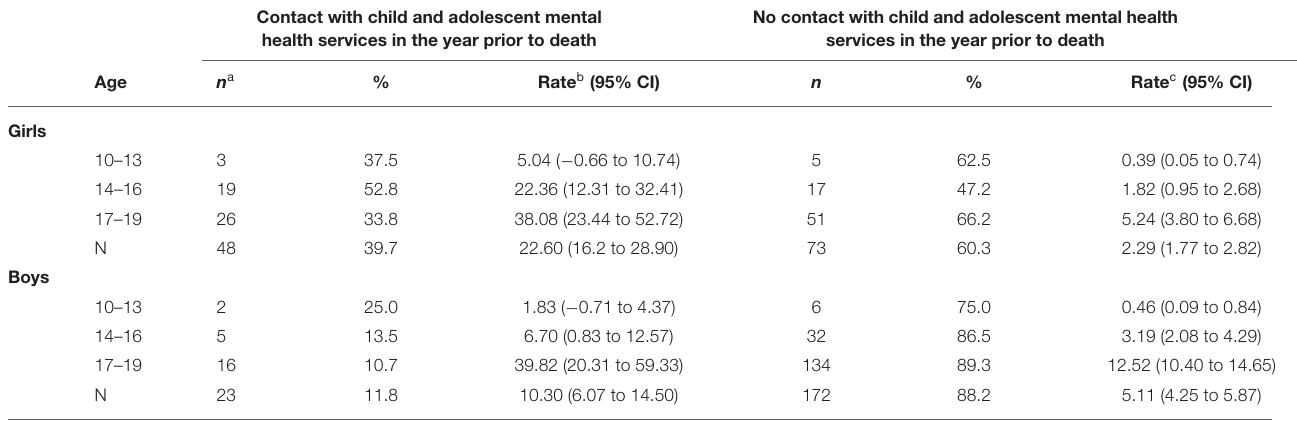
TABLE 1 | Number of suicides and suicide rates in children and adolescents with and without contact in Child and Adolescent Mental Health Services (CAMHS) in the year prior to death. Contact with child and adolescent mental health services in the year prior to death